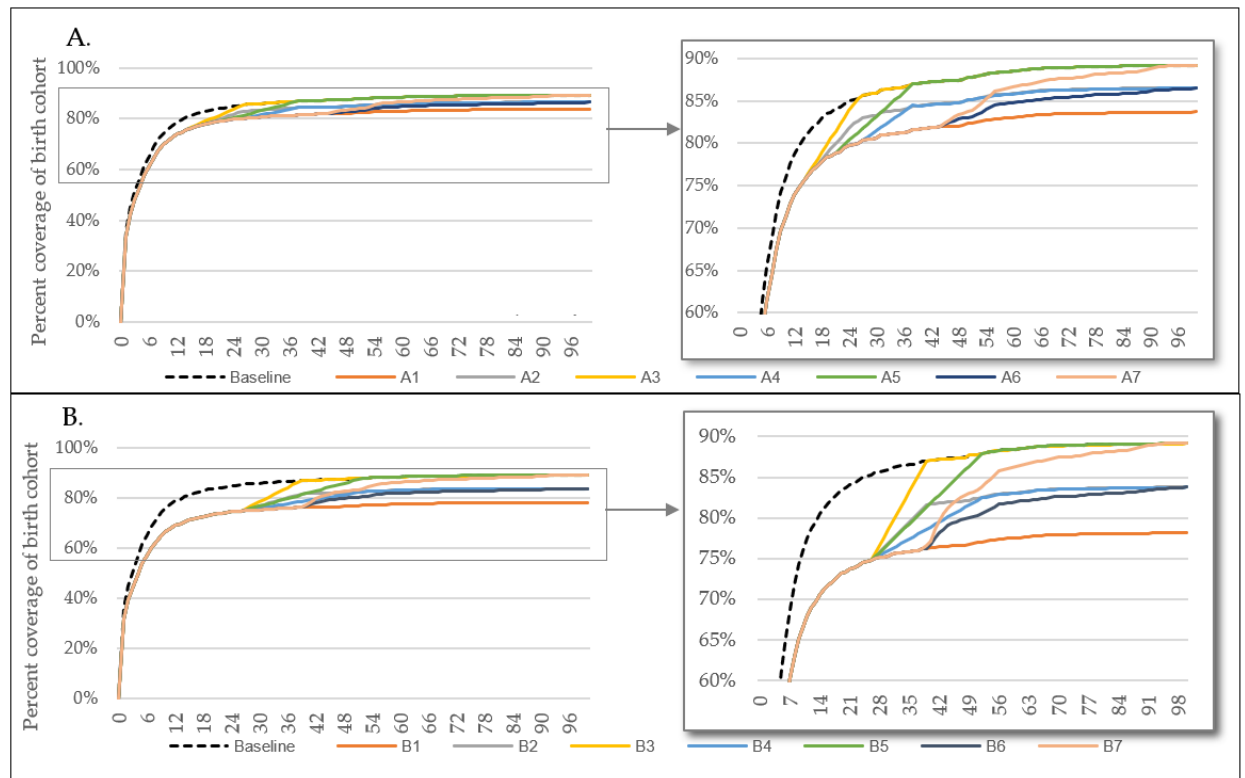
Figure 1. Vaccine coverage scenarios by age in weeks compared to baseline of no disruption; ( A ) Scenarios A1 to A7 e.g., disruption for 3 months; ( B ) Scenarios B1 to B7 e.g., disruption for 6 months.